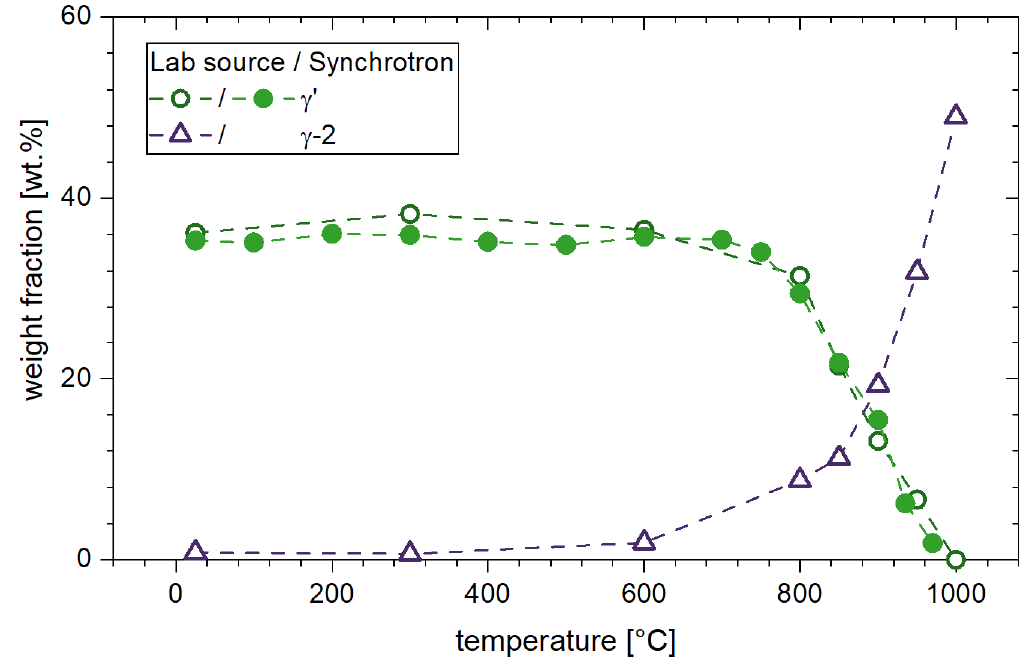
Figure 8. Temperature-dependent weight fractions of the γ′ and γ-2 phases, which were determined by lab-source and synchrotron XRD. The synchrotron data are shown up to the first heating plateau of 970 °C.